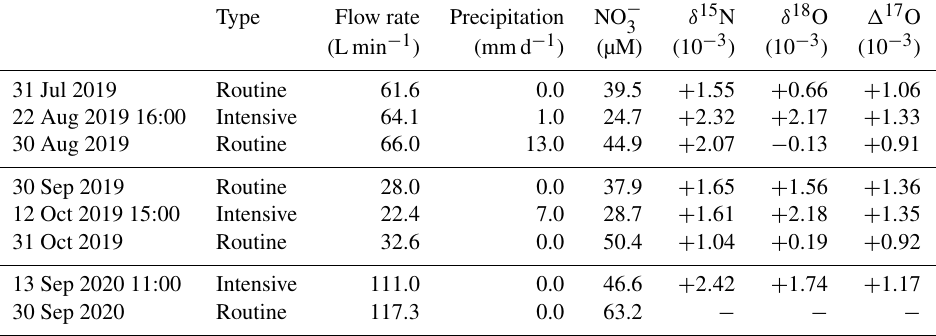
Table A1. Comparison of both concentration and isotopic compositions ( δ 15 N, δ 18 O, and (cid:49) 17 O) of stream nitrate between those taken at the beginning of intensive observations using the automatic sampler and those taken manually on the days nearby during routine observations.